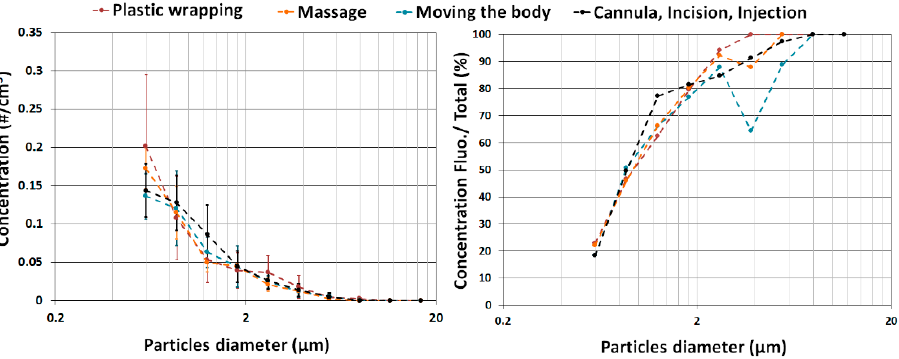
Figure 5. Fluorescent particle concentration ( left ) and fluorescent fraction ( right ) by particle size for the three most emissive tasks observed in lab A.